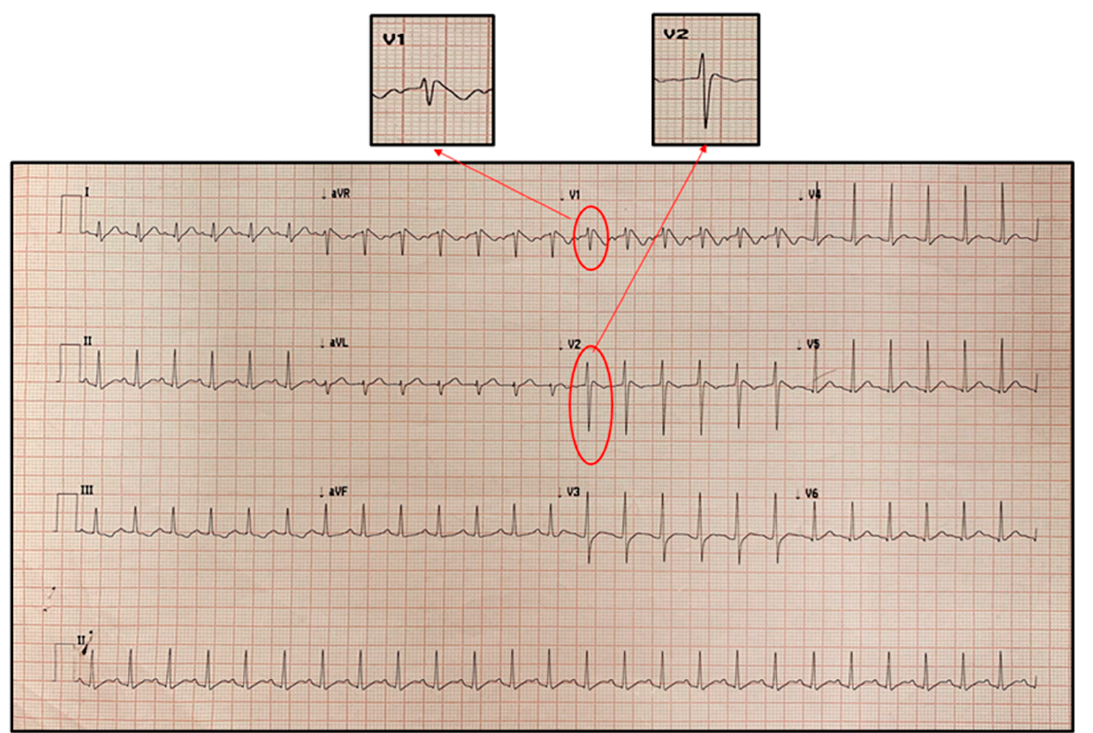
Figure 1. First electrocardiogram recorded on admission showing Brugada type 1 pattern in V1 and V2. It is characterized by a coved ST-segment elevation displaying J-point amplitude or ST-segment elevation ≥ 2 mm, followed by a negative T wave in more than one right precordial leads (V1 to V3).